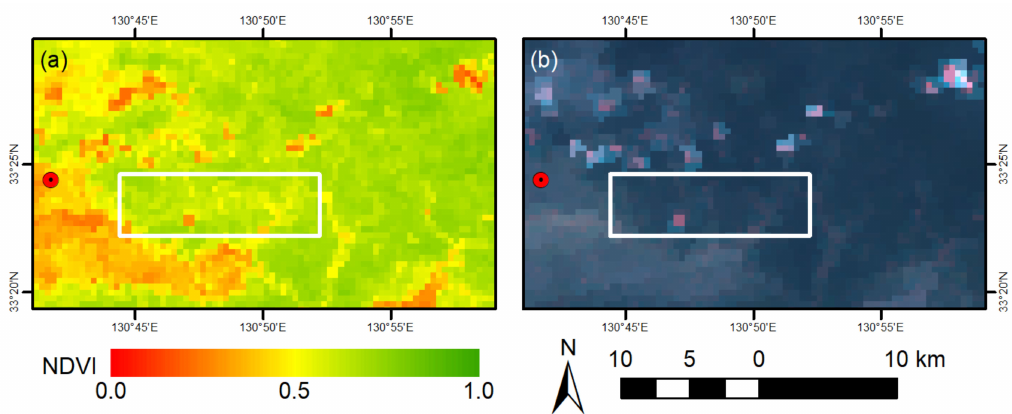
Figure 9. VIIRS images over the study area for 13 July 2017: ( a ) NDVI and ( b ) natural-color composite. The VIIRS overpass time was ~12:50 p.m. JST on the date. The white line boxes represent the region used for the correlative analysis (see Section 3.1 and Figure 6). The map was created with ArcGIS ®